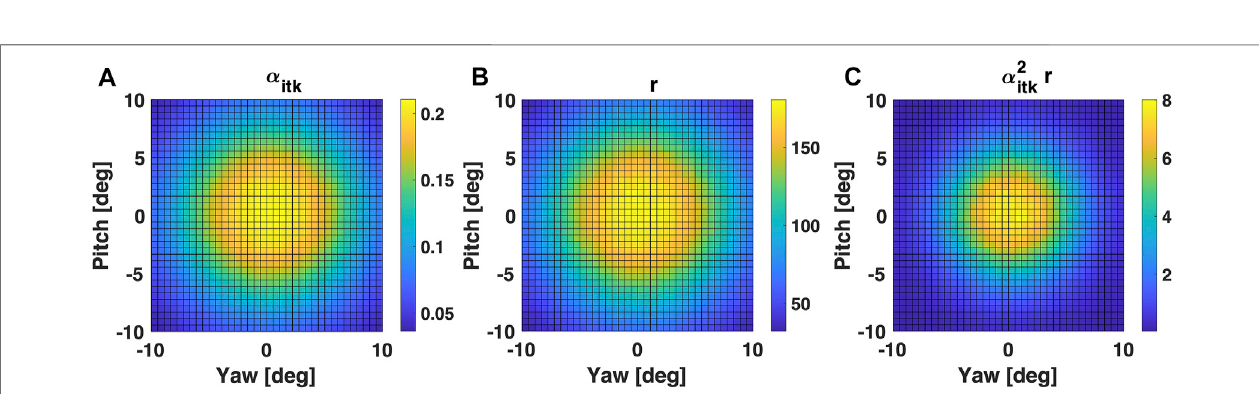
FIGURE 13 | Impact of S/C yaw and pitch angles on the reference intake test case (A) transmission, (B) compression, and (C) intake fi tness for a 50/50 N 2 /O composition. Figure resolution: 37 × 37 simulations. Simulated particles for each simulation: 1e5.